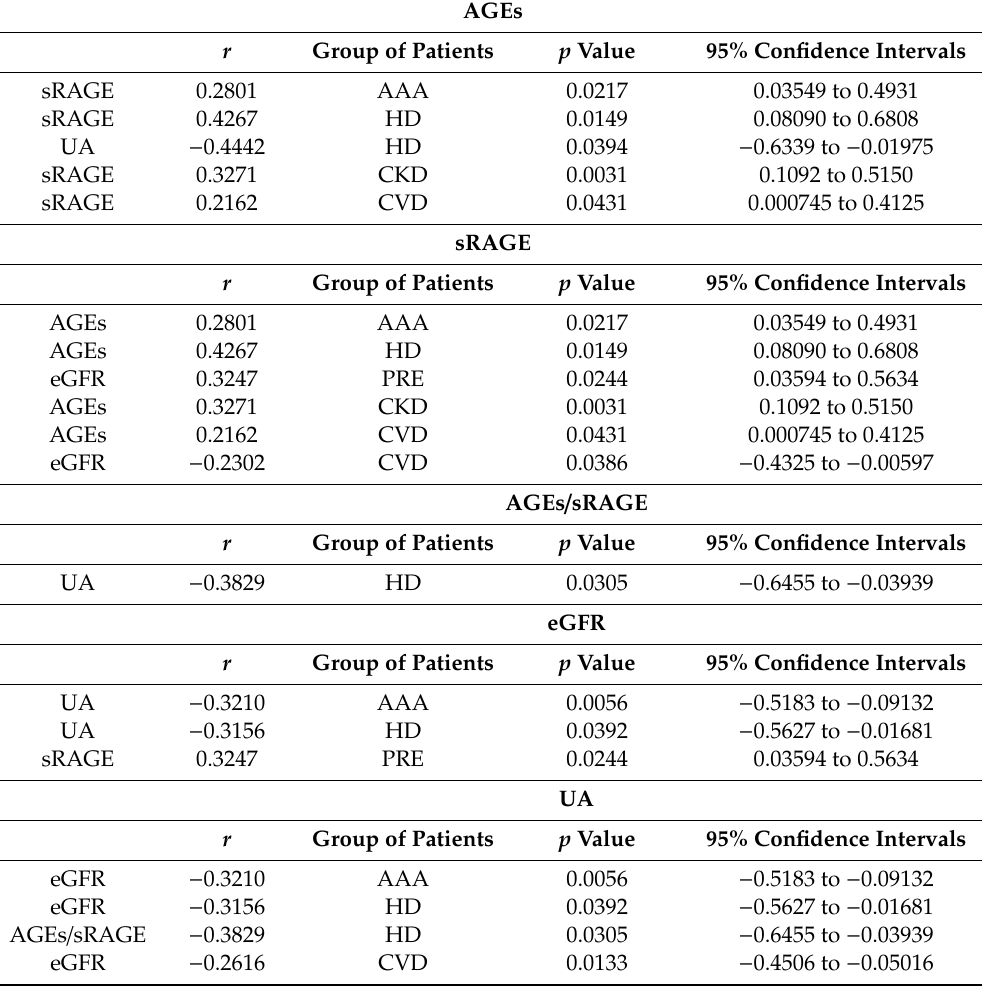
Table 4. The correlation coe ffi cients for AGEs, sRAGE, AGEs / sRAGE, and UA in the studied groups of patients.